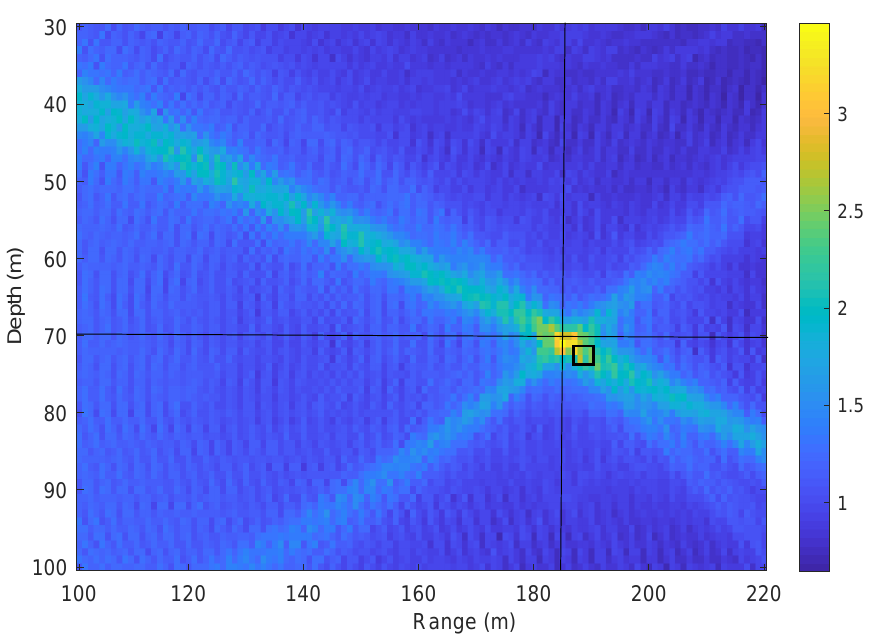
Figure 4. An example of the non-coherent AF in (7) for the parameters of acoustic environment in Table 1. The crossing point of the horizontal and vertical black lines indicates the true receiver position. The black square indicates the position estimate (the AF maximum). Here we use the acoustic environment with the uniform SSP as shown in Figure